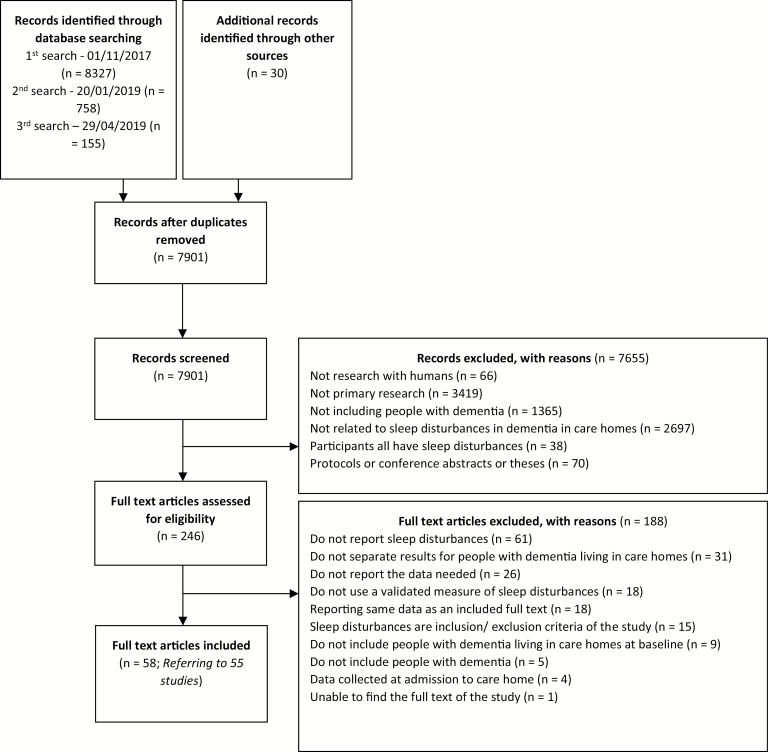
PRISMA flow diagram.